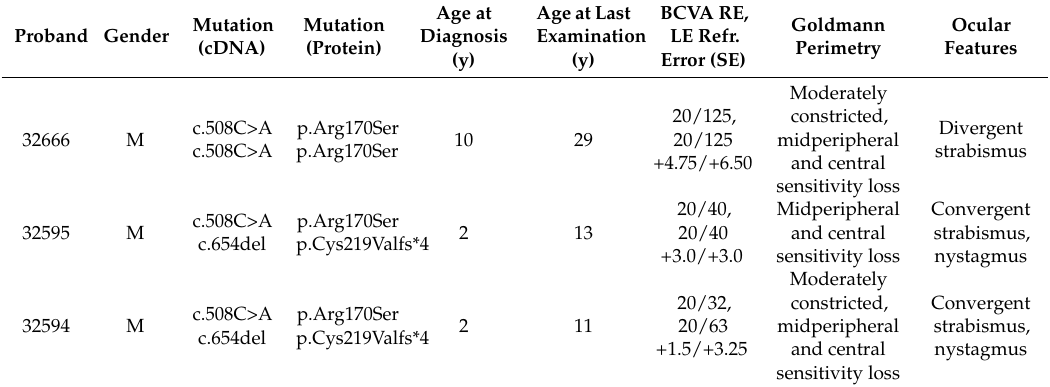
Table 1. Overview of clinical and genetic findings in patients with autosomal recessive NRL mutations. Mutation Proband Gender (cDNA)